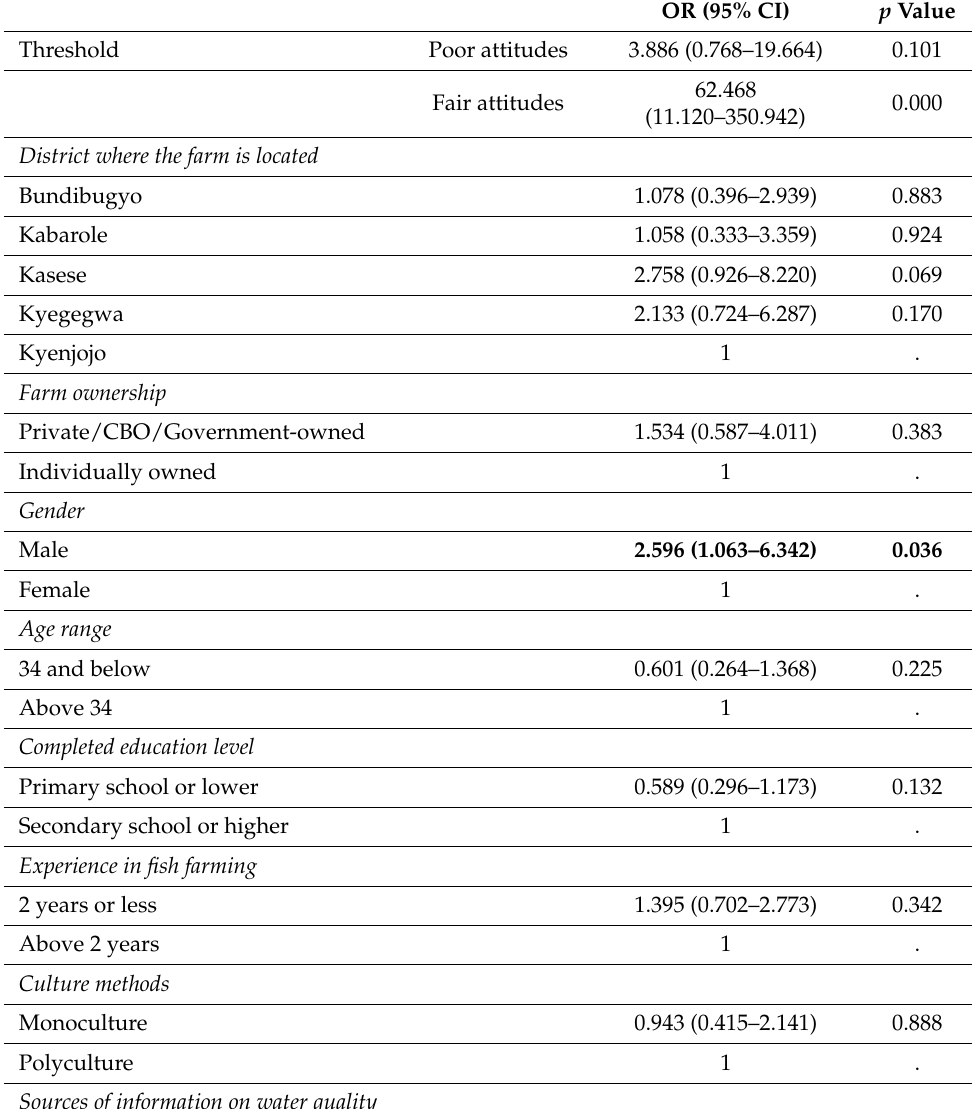
Table 7. Ordinal logistic regression analysis of factors associated with attitudes towards water quality management among fish farmers of the Rwenzori